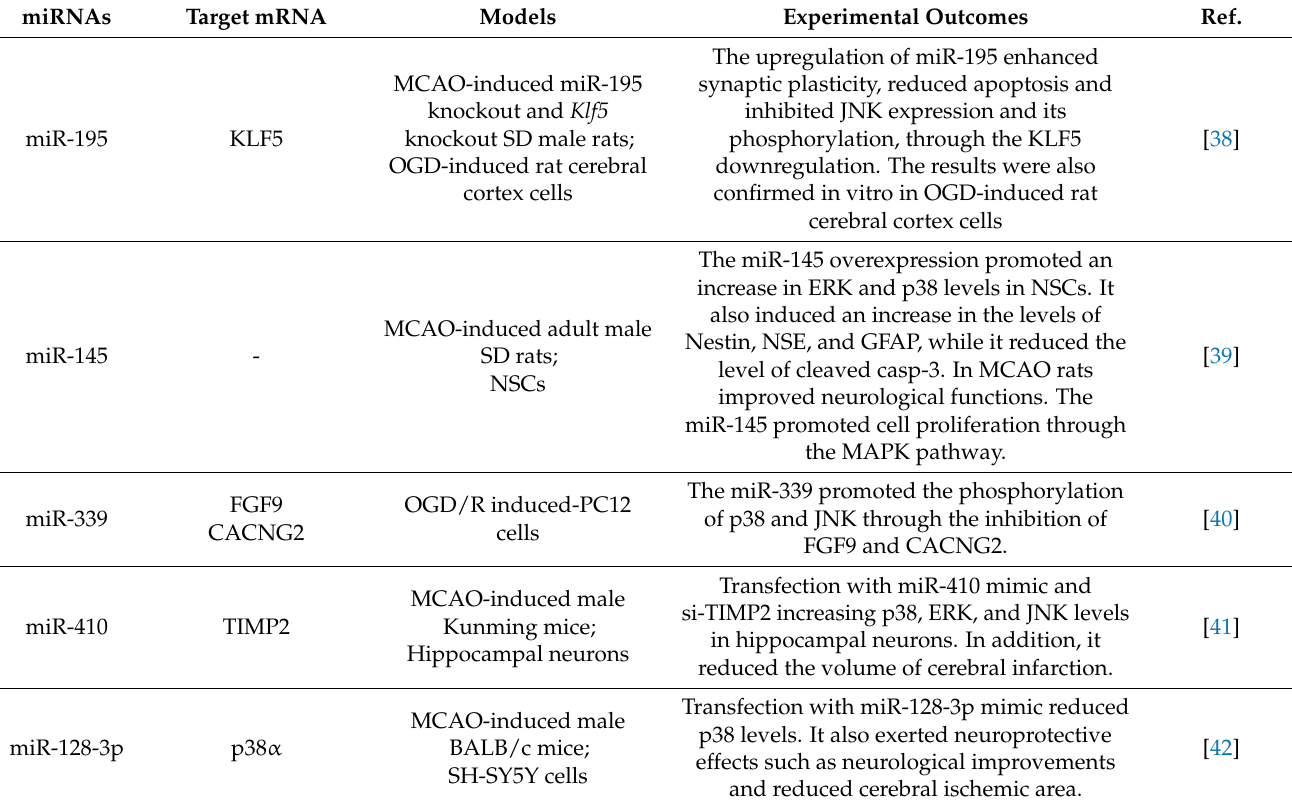
Table 1. Experimental models of miRNAs involved in MAPK pathway linked to IS. miRNAs Models Experimental Outcomes